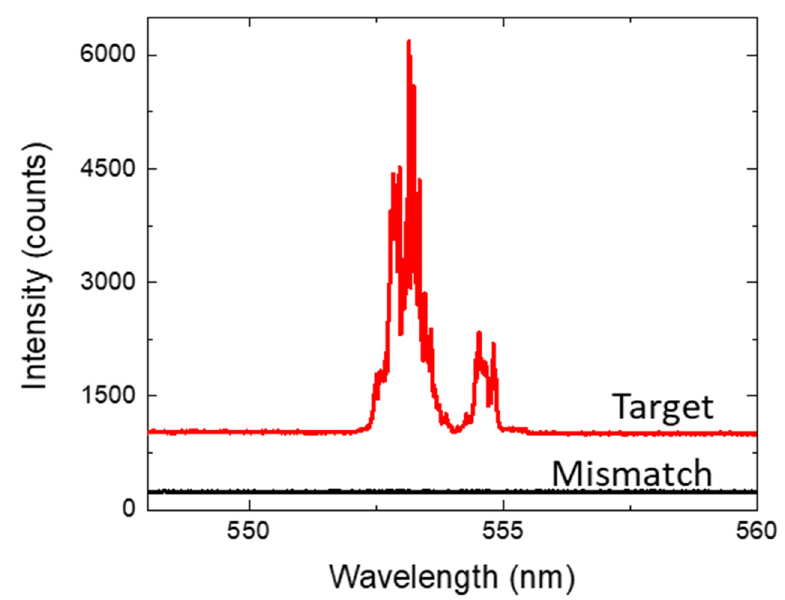
Figure 2. Laser emission spectra from the target DNA and base mismatched DNA when pumped with the same energy density. Note that the curves were vertically shifted for clarity.